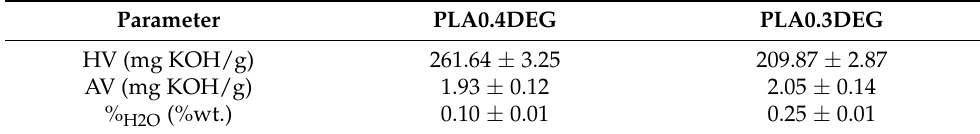
Table 2. Analytical test results of new eco-polyols based on waste PLA.